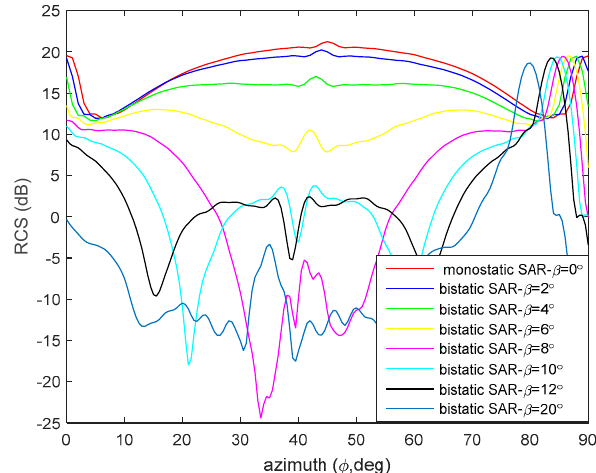
Figure 7. The bistatic RCS azimuth pattern of the TCR based on FEKO electromagnetic simulations.